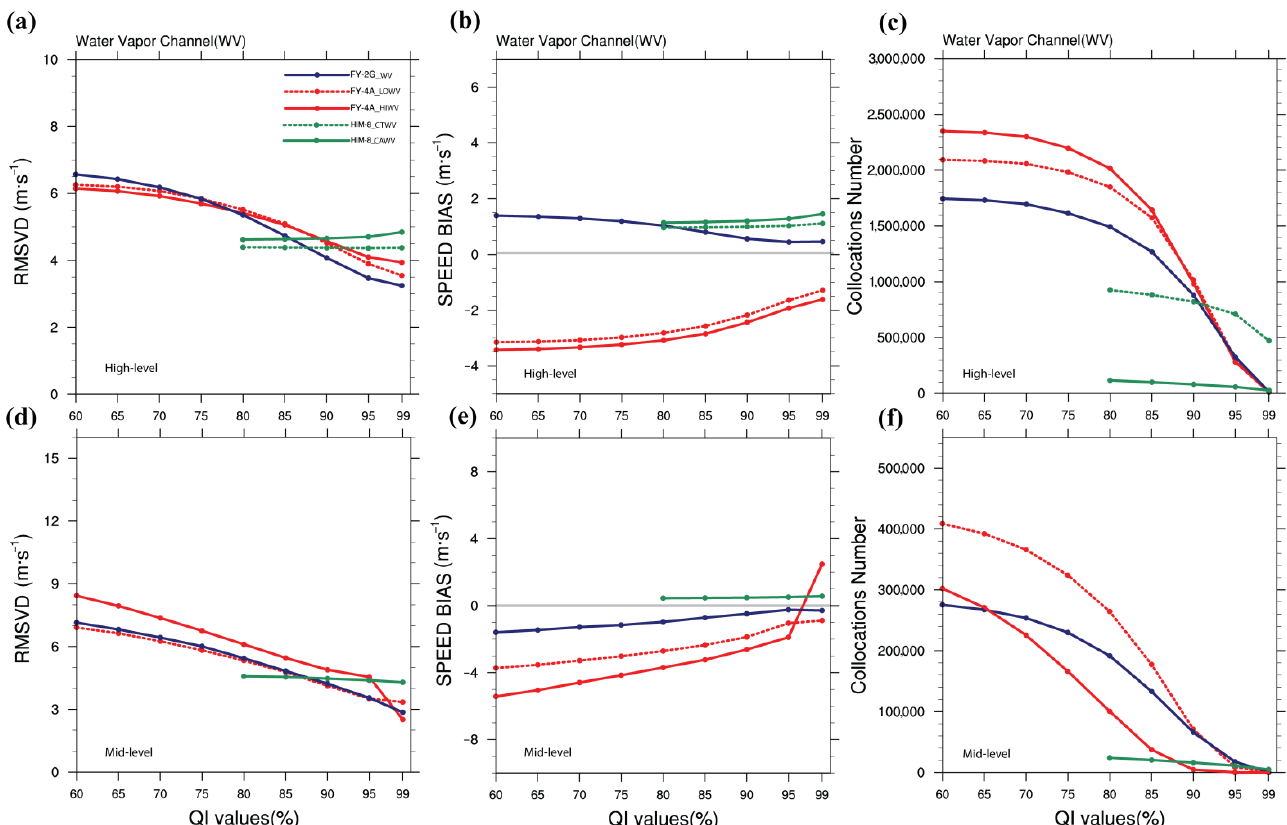
Figure 6. The mean RMSVD ( a , d ), BIAS ( b , e ), and numbers of collocations ( c , f ) of WV AMVs for different levels from high, and mid-levels using variable QI values from 60 to 100% in December 2018. The WV AMVs data was not available for a low-level.